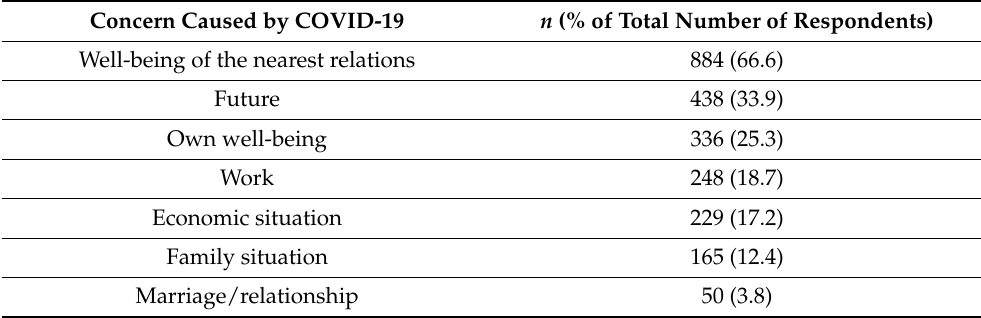
Table 2. Concerns caused by COVID-19 among respondents in the anonymously completed self- report survey in the Faroe Islands conducted from 13 April until 4 May 2020, n = 1328.